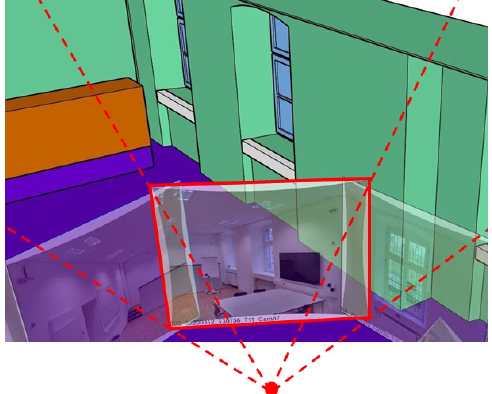
Figure 2. Discrepancy between measured edge (as-built) and modeled edge ( as-planned) Line features usually serve well as geodetic references in in- door scenes in order to estimate the camera orientation.